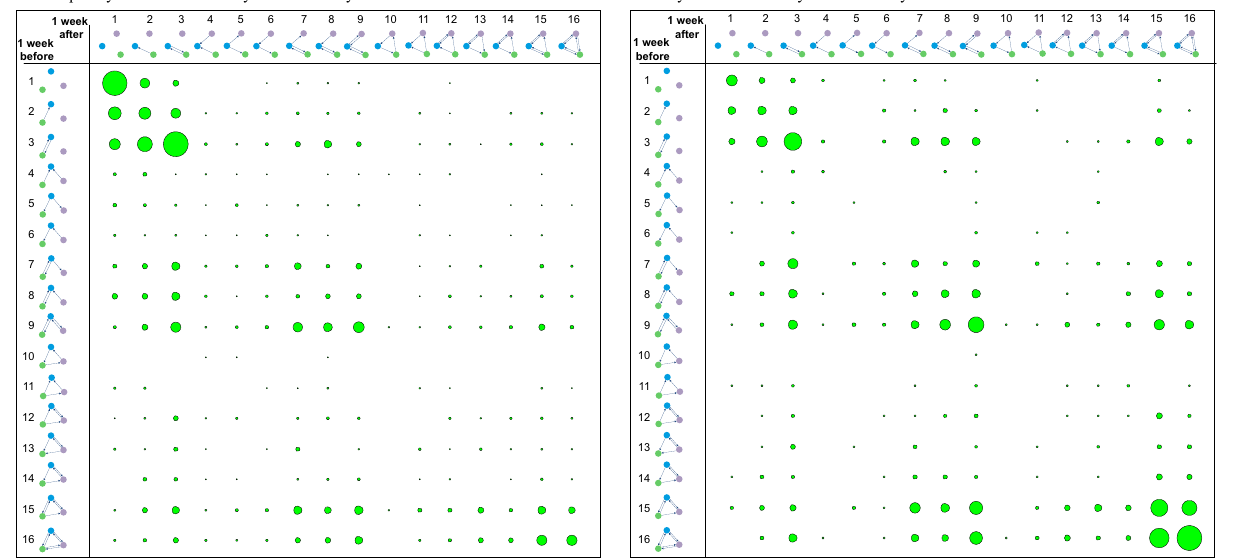
Fig. 4 Embeddedness structure and triadic motifs before and after earthquake. Change in family triadic motif structures (normalized) before vs. after the earthquake for completely unembedded ( A ) and fully embedded families ( B